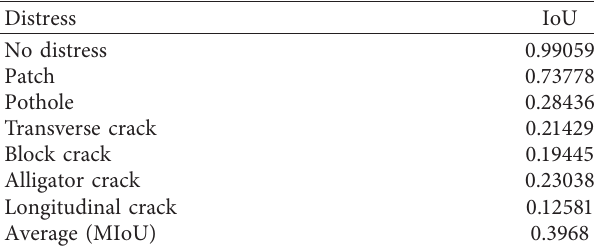
Table 6: IoU of different labels using